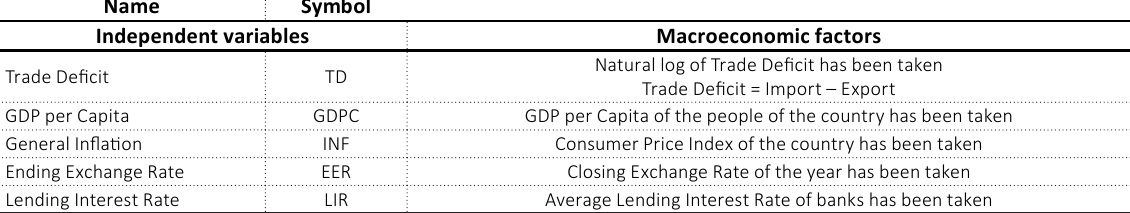
Table 1 (cont.). List of variables and their proxies and